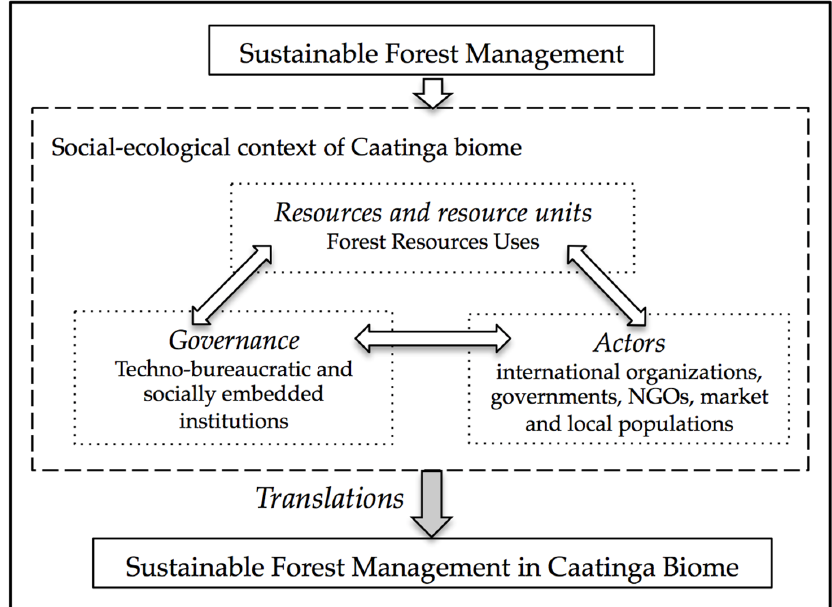
Figure 2. Translations of SFM in a social-ecological system framework (Elaborated by the authors cf. [26,27].